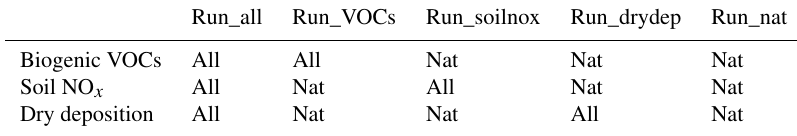
Table 1. GEOS-Chem simulations to quantify surface ozone response to nitrogen deposition from each process and the net effect ∗ .